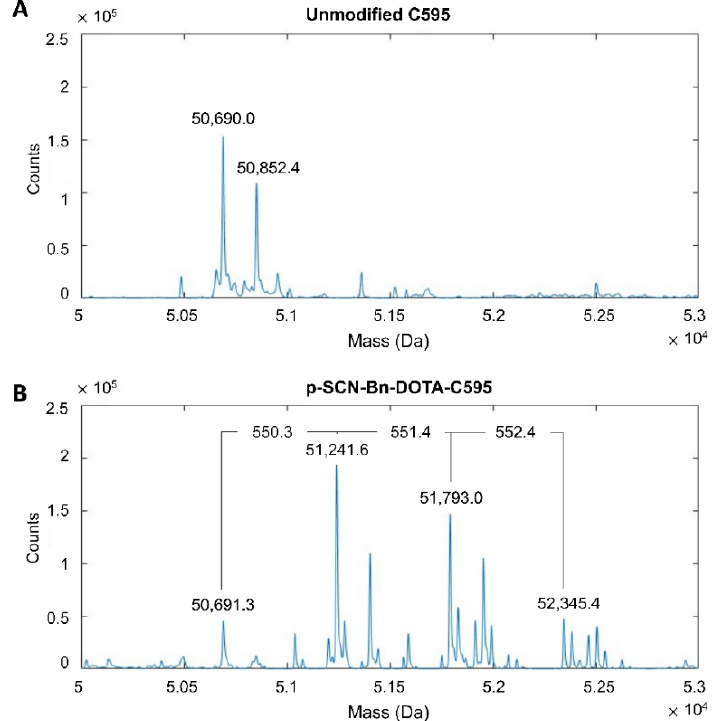
Figure 2. Mass spectra of the heavy chains of ( A ), unmodified C595 and ( B ), p-SCN-Bn-DOTA-C595 conjugate.